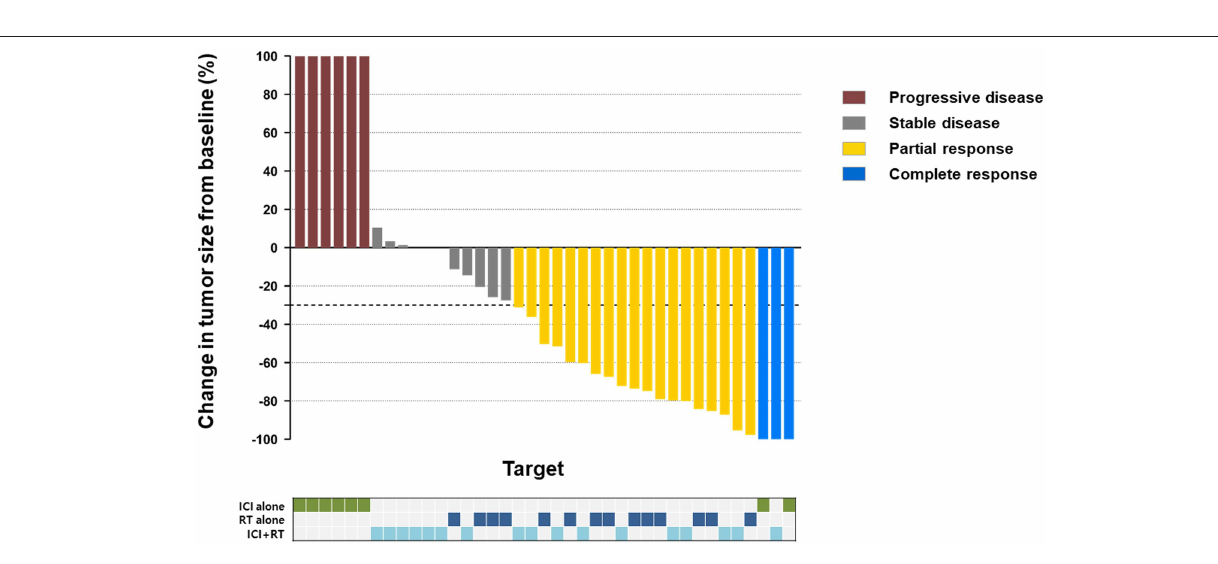
FIGURE 3 | Waterfall plot of best responses of all lesions according to the treatment